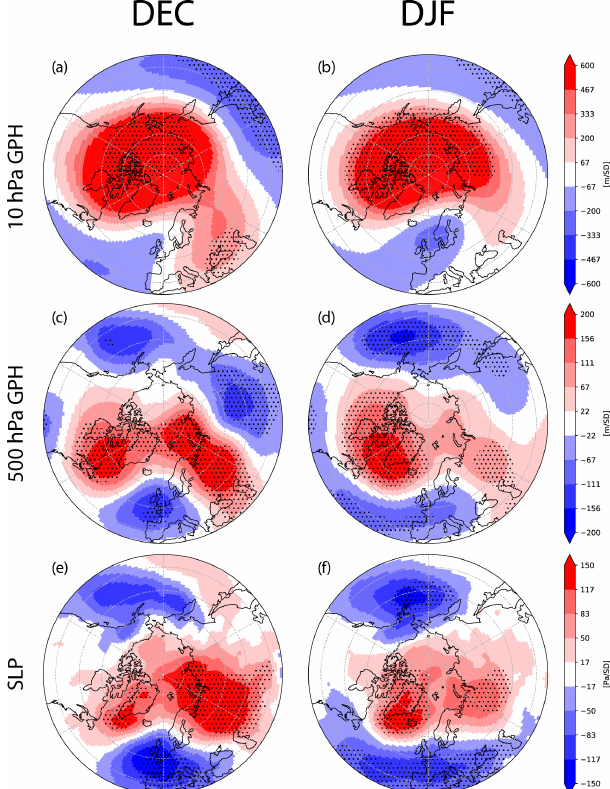
Figure 5. ERA20C anomalies of 10hPa (a, b) geopotential heights, (c, d) 500hPa geopotential heights and (e, f) sea level pressure re- gressed onto the snow dipole index in November from ERA20C covering 1901–2010 for December and DJF mean. Shading indi- cates 95% significance level. For monthly anomalies see Fig.